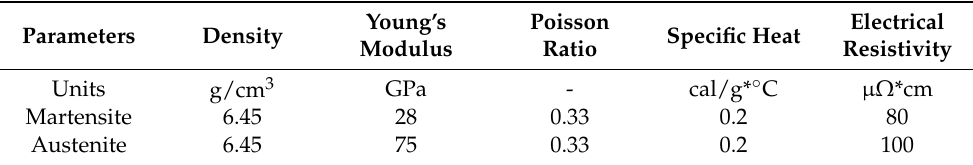
Table 1. Manufacturer’s stated properties of Flexinol wires [30].